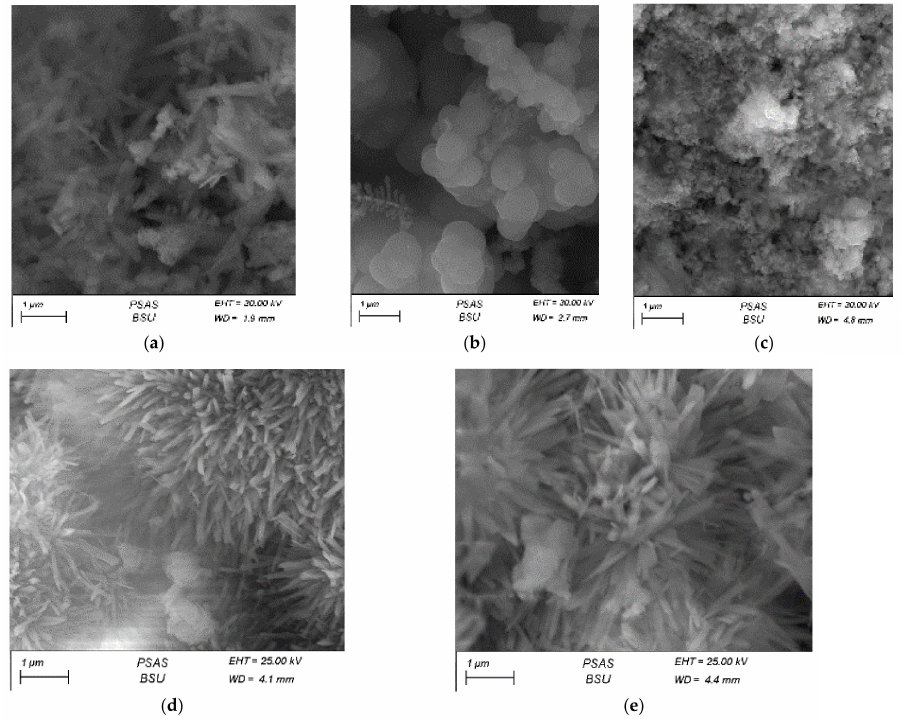
Figure 4. ( a ) SEM images of the anodized copper foam in 0.1 M K 2 CO 3 at 5, ( b ) 10, ( c ) 15, ( d ) 20, and ( e ) 25 V (scale bare 1 µ